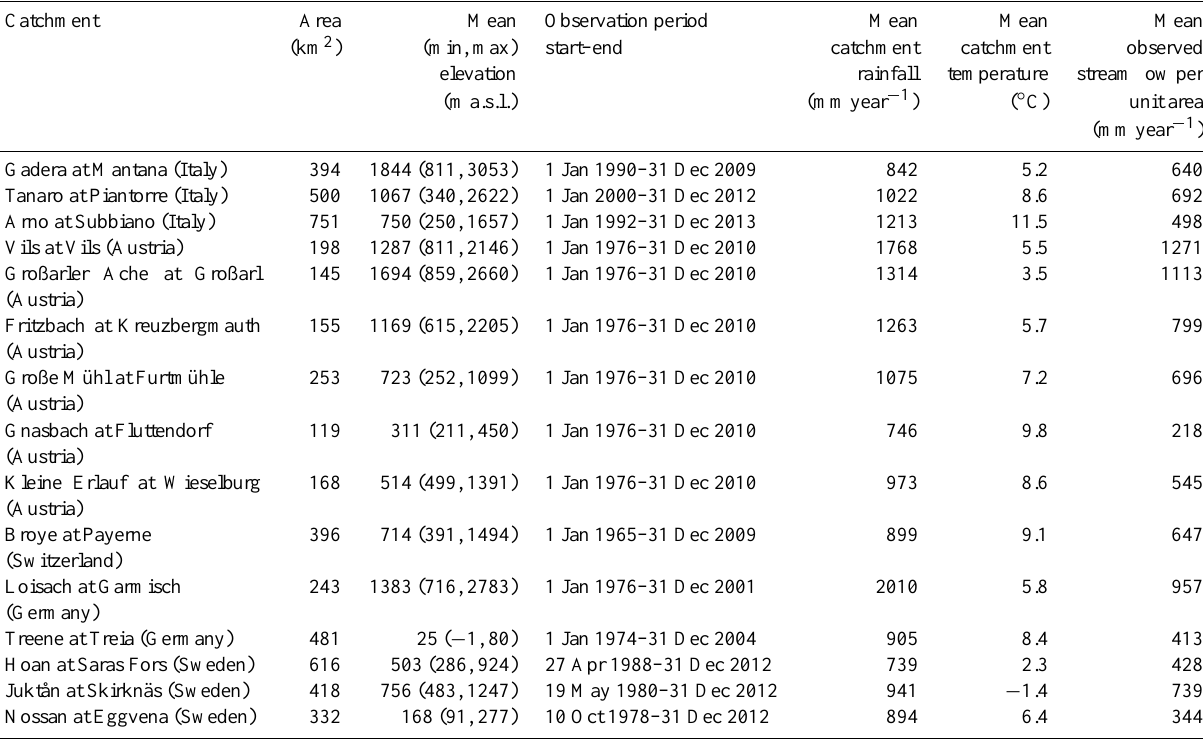
Table 1. Summary of the key geographical and hydrological features for the 15 catchments considered in the first collaborative experiment of the SWITCH-ON Virtual Water-Science